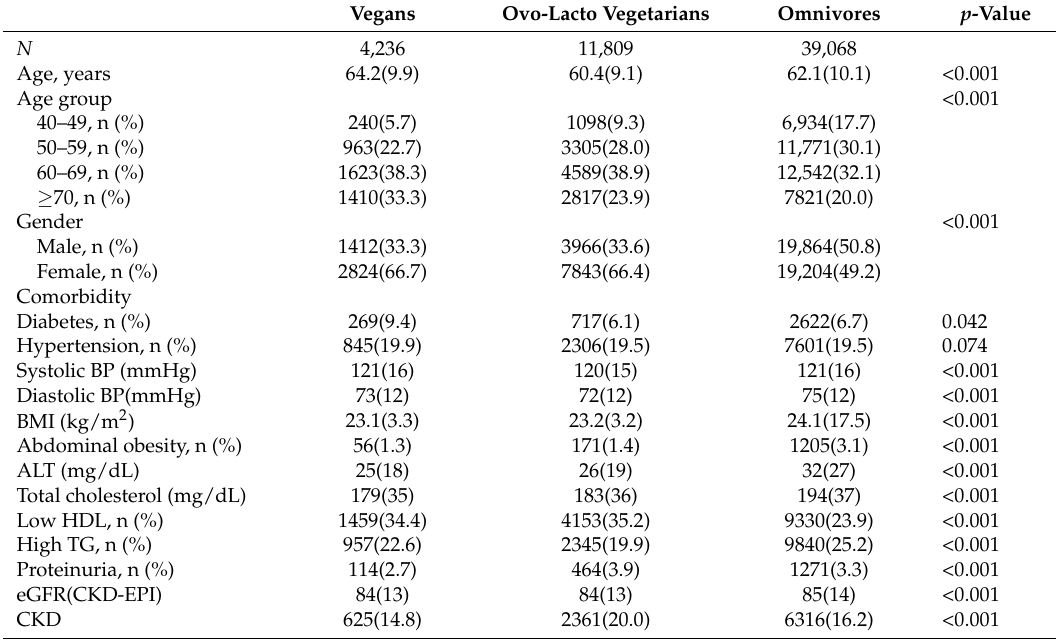
Table 1. Characteristics of individuals according to different diet patterns.